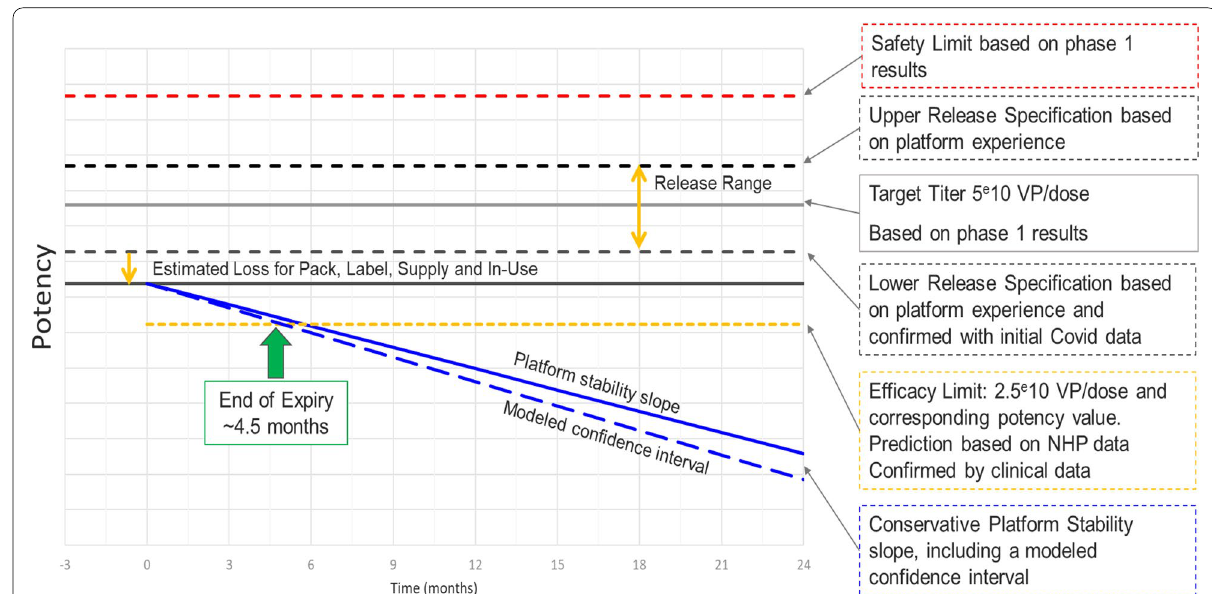
Fig. 2 Janssen Shelf‑life Model used for COVID‑19 Vaccine. Excerpt from Scholten, A., Defining Shelf‑Life for the COVID‑19 Vaccine EUA, AAPS Vaccine Stability Workshop, March 24‑25,